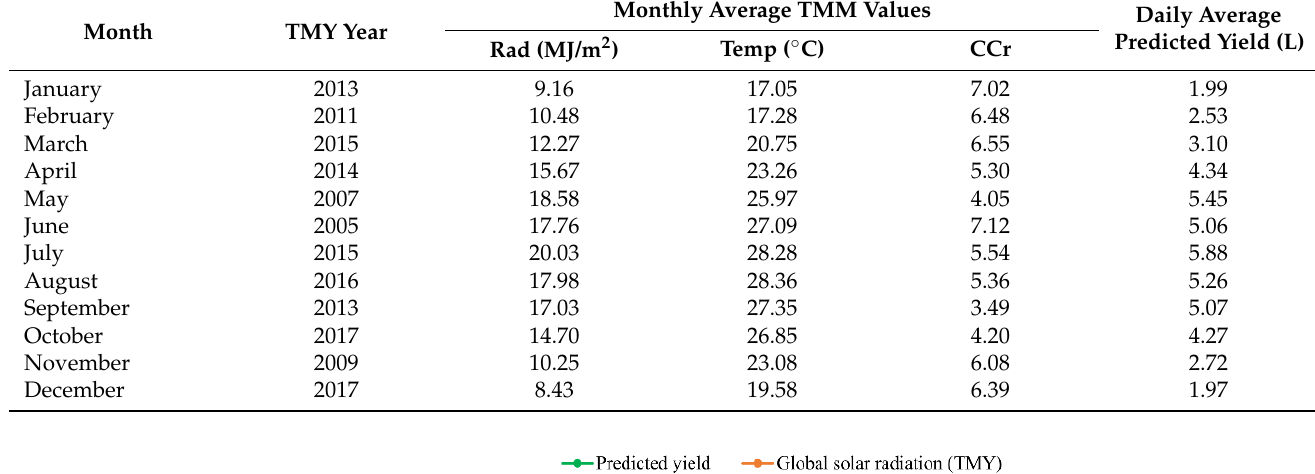
Table 9. Monthly average values of the three predictor variables and predicted yield for each TMM.